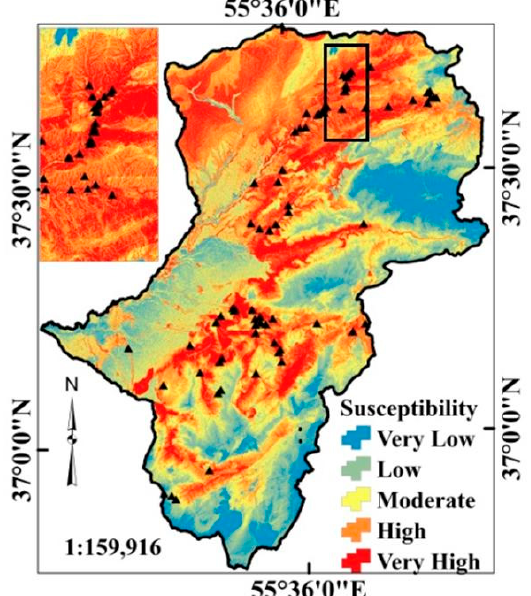
Figure 6. Landslide susceptibility map based on the FLDA model.